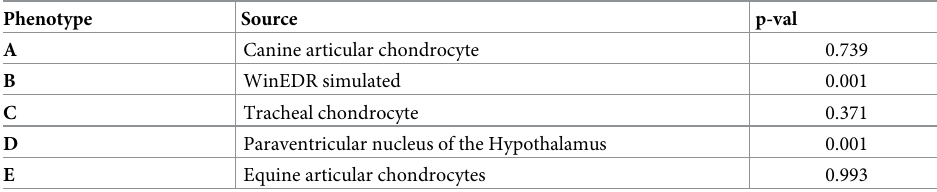
Table 4. Statistical separation of UMAP clusters between each real dataset and its GAN simulated